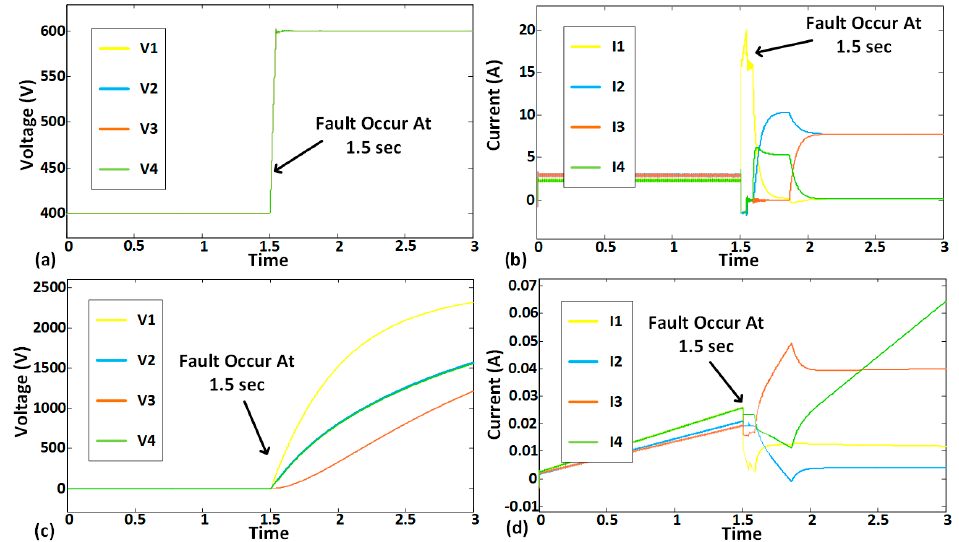
Figure 8. Results of proposed secondary control simulation: ( a ) node voltages; ( b ) node current; ( c ) voltage correction term; ( d ) current correction term.